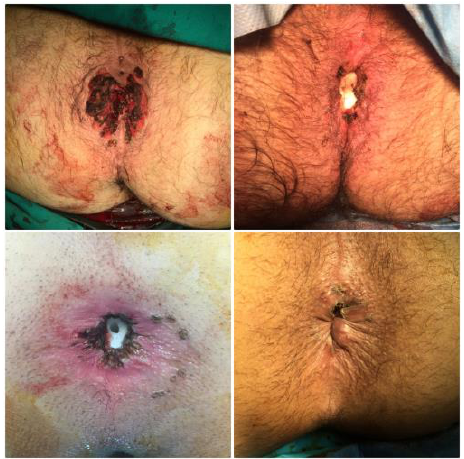
Figure 8. Final results after surgical excision of several CA lesions combined with electrocautery ablation, ultrasound scissors and diathermy.